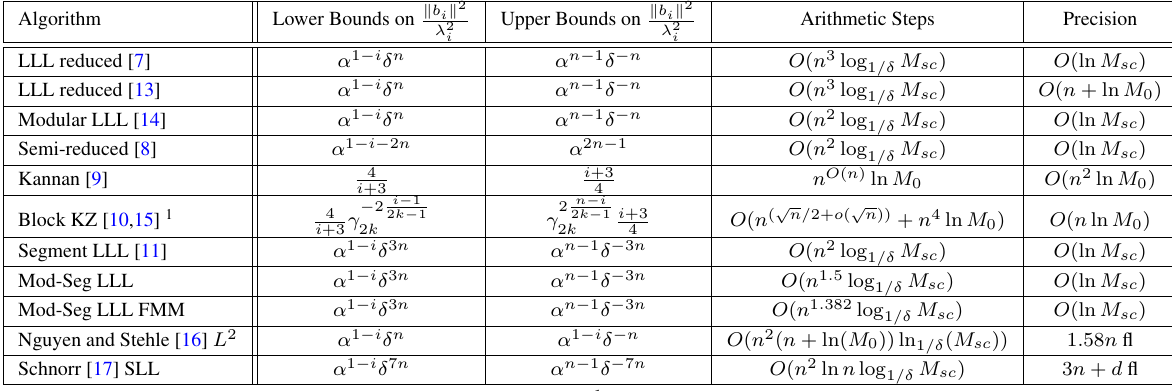
Table 1. Summary of various LLL-related